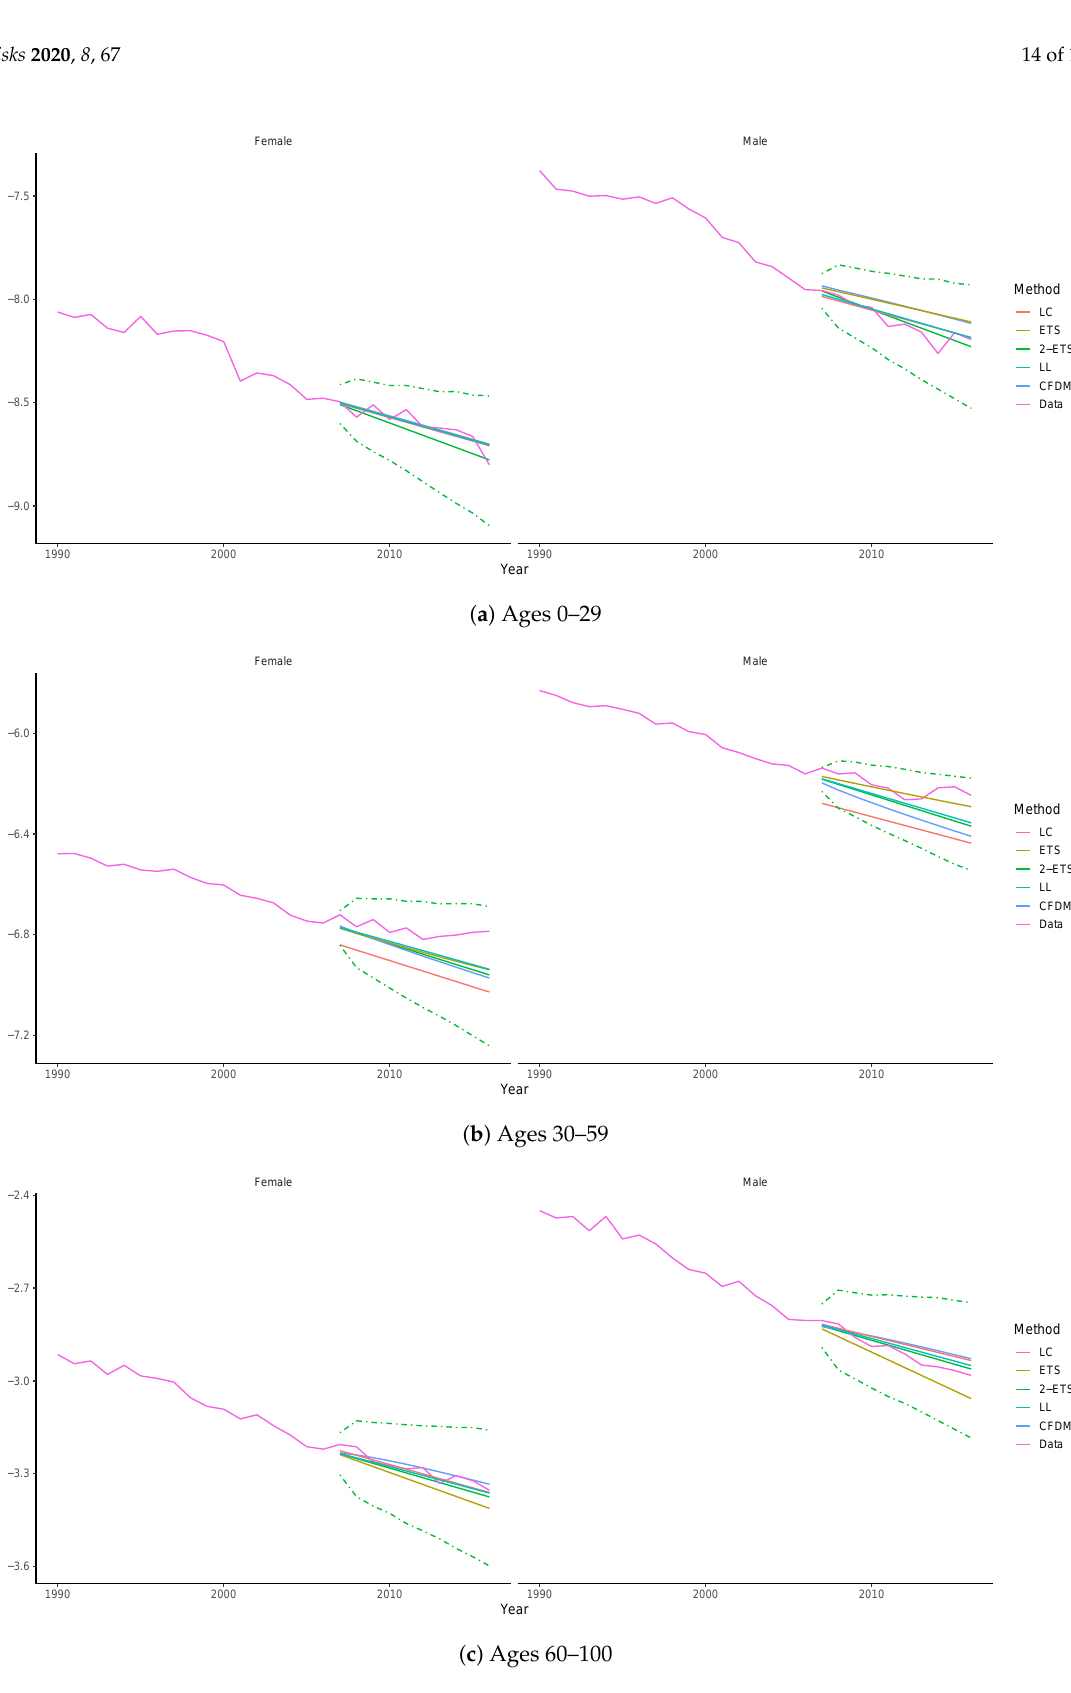
Figure 7. Predicted vs actual log mortality rates (averaged over different age groups) for Australia: 1990–2016. Note: Solid lines display forecast and actual mortality rates averaged over all ages, and dashed lines are the PIs produced under the 2-ETS